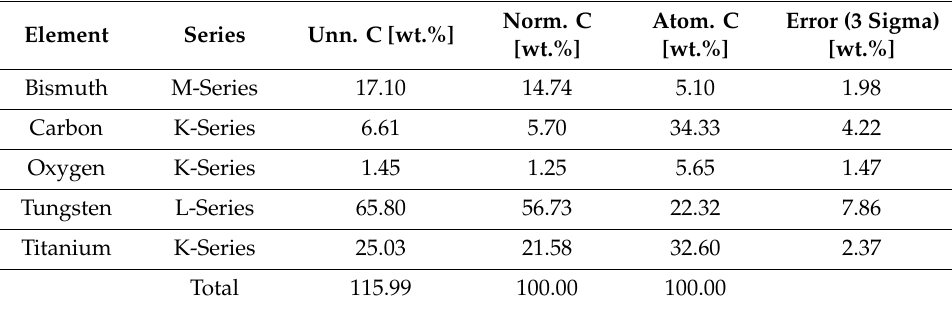
Table 1. Elemental composition of Bi 2 WO 6 /C-dots/TiO 2.